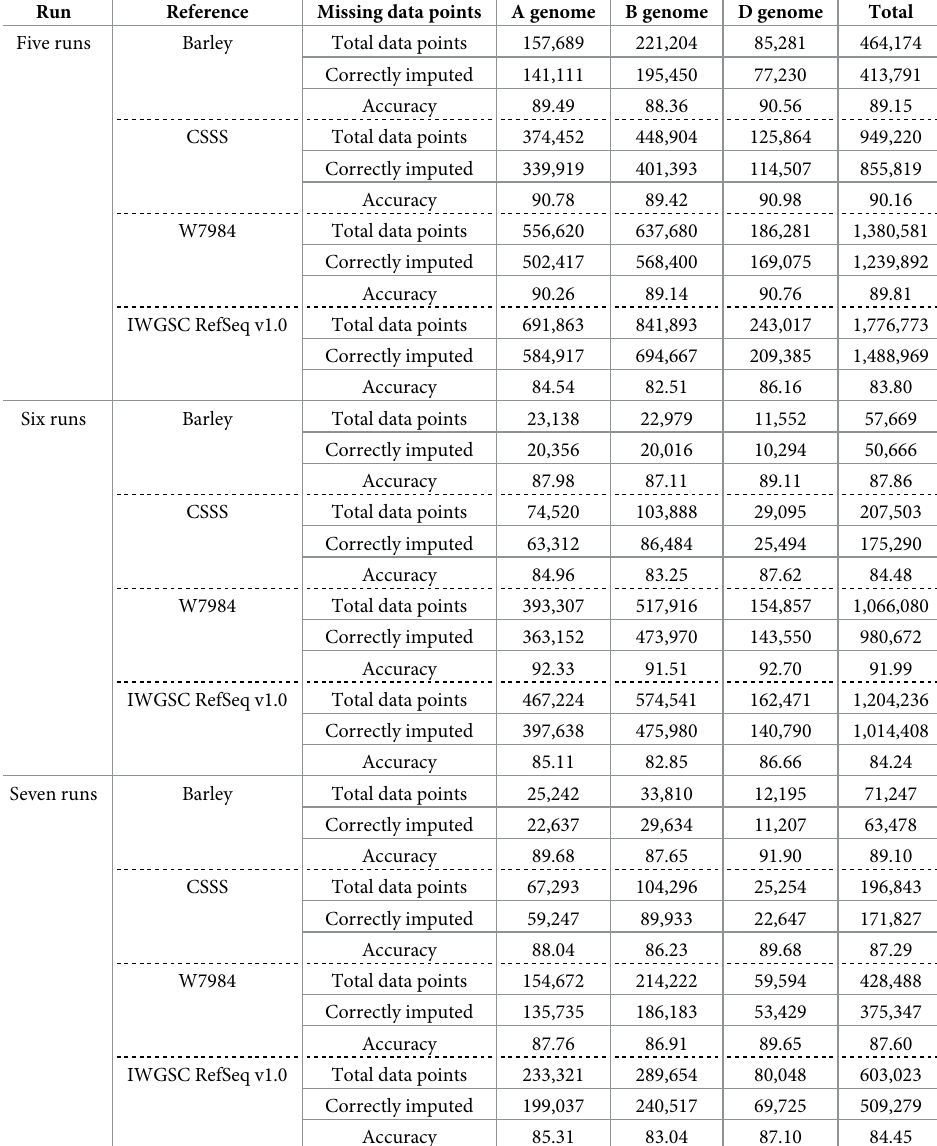
Table 6. Numbers of data points per chromosome after imputation with barley genome, Chinese Spring survey sequence (CSSS), W7984 and IWGSC RefSeq v1.0 references and imputation accuracy calculated by comparing imputed data of five, six and seven runs with actual SNP data generated from eight sequencing